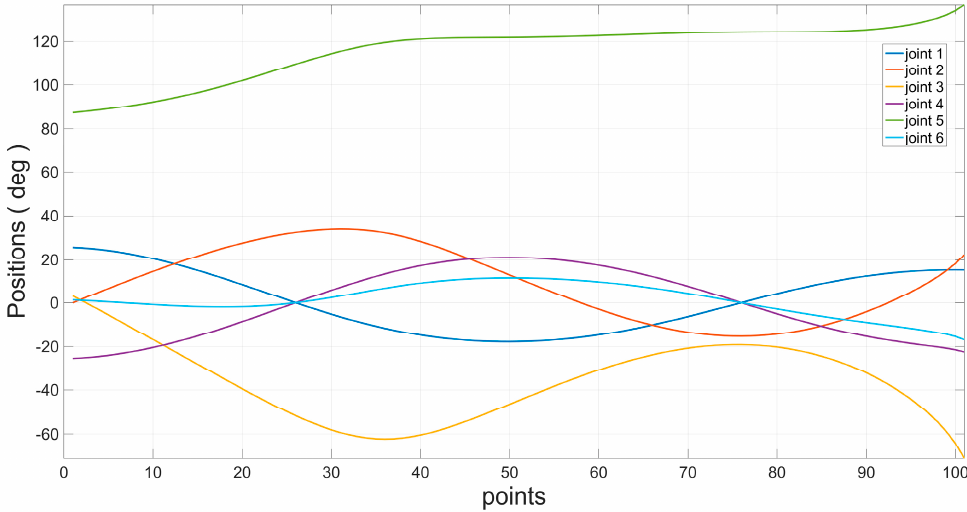
Figure 4. The joint trajectory after the inverse kinematics solution.